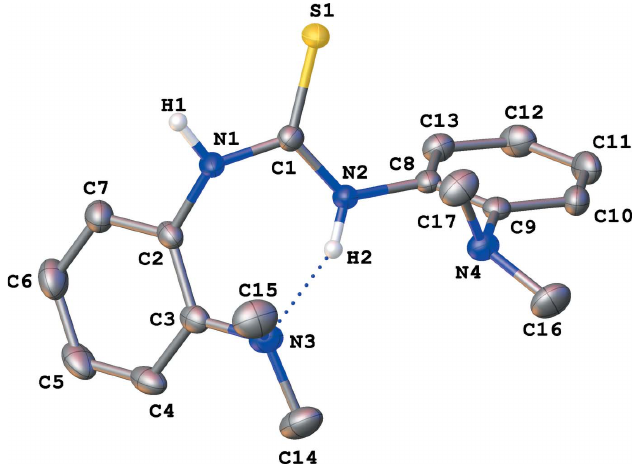
Figure 1 Molecular structure of 1 with displacement ellipsoids at the 50% probability level. Hydrogen atoms attached to carbon were omitted from the